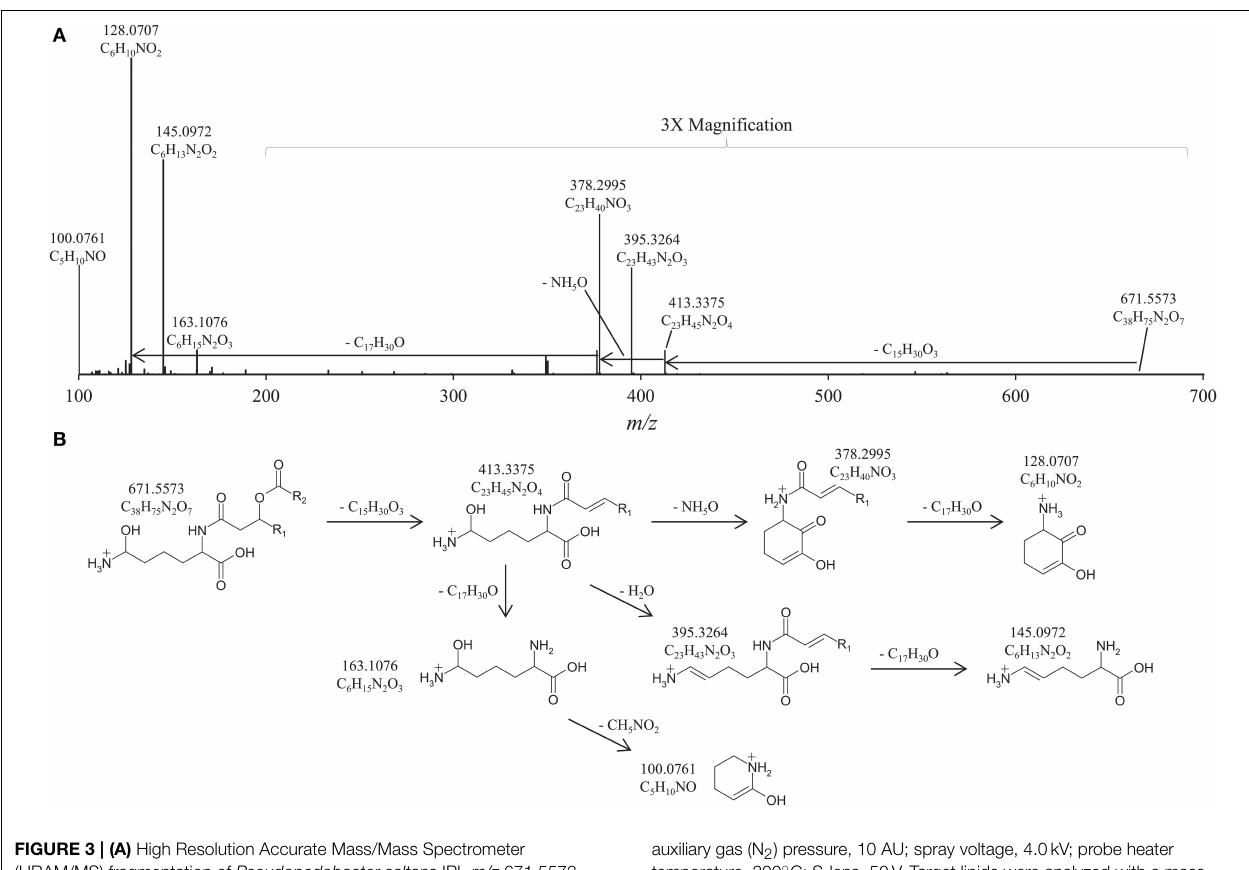
auxiliary gas (N 2 ) pressure, 10 AU; spray voltage, 4.0kV; probe heater temperature, 300 ◦ C; S-lens, 50V. Target lipids were analyzed with a mass range of m/z 400–1000 (resolution, 70,000), followed by data dependent MS 2 (resolution, 17,500), in which the five most abundant masses in the mass spectrum were fragmented successively (normalized collision energy, 35; isolation width,